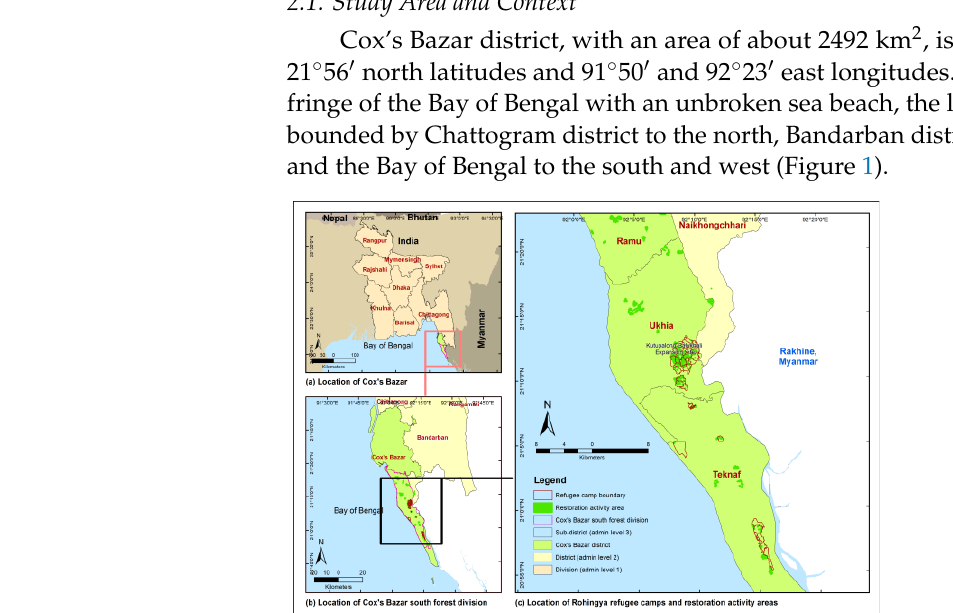
Figure 1. Location of Cox’s Bazar district (a), Cox’s Bazar south forest division (b), refugee camps and areas of restoration activities (c).